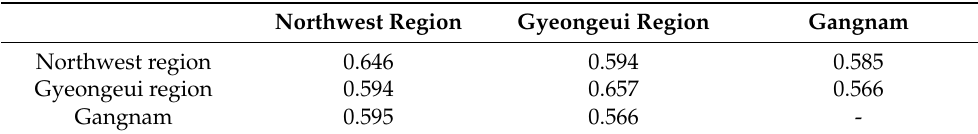
Table 3. Correlation analysis of jeonse price between